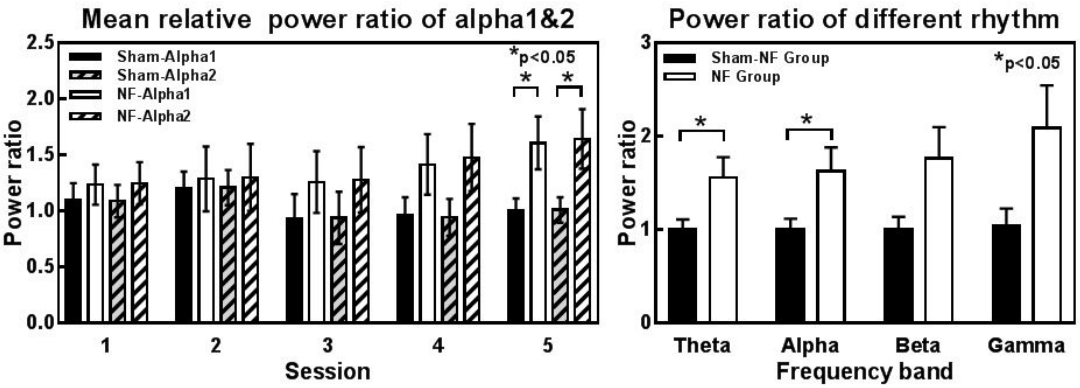
Figure 4. Changes in the relative alpha rhythm throughout neurofeedback training in the NF group and Sham-NF group. ( a ) Mean relative alpha power ratio in both groups. * represents ( p < 0.05) when compared to the relative alpha power of session 5 of the sham-NF group. # represents ( p < 0.01) when compared to the relative power of session 1 of NF group; ( b ) Numbers of subjects with relative alpha power higher than session 1 during training sessions 2–5 in both groups.